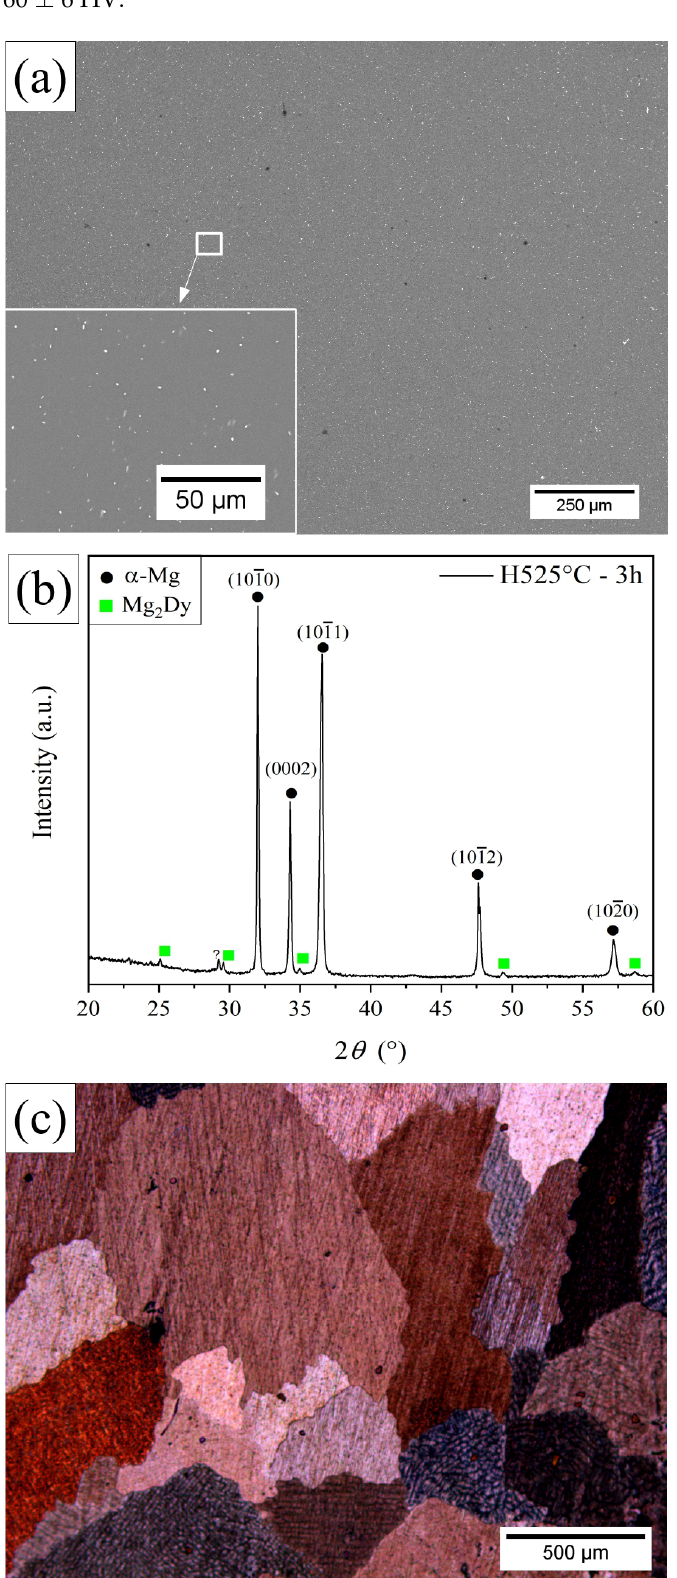
Figure 1. ( a ) SEM/BSE micrograph, ( b ) XRD pattern and ( c ) LOM micrograph of the H525 ◦ C-3 h